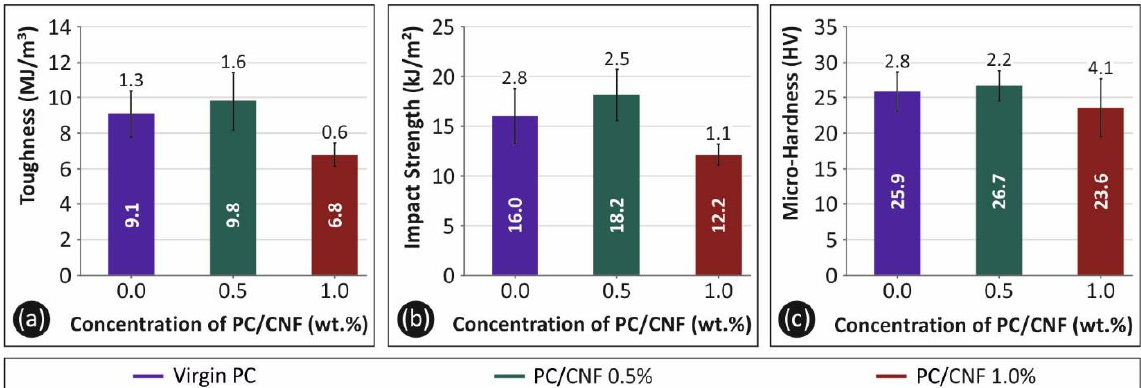
Figure 5. ( a ) Calculated average toughness (MJ/m 3 ), ( b ) Impact strength (kJ/m 2 ), ( c ) Average Vickers microhardness (HV) all presented in a comparable way for all tested materials.